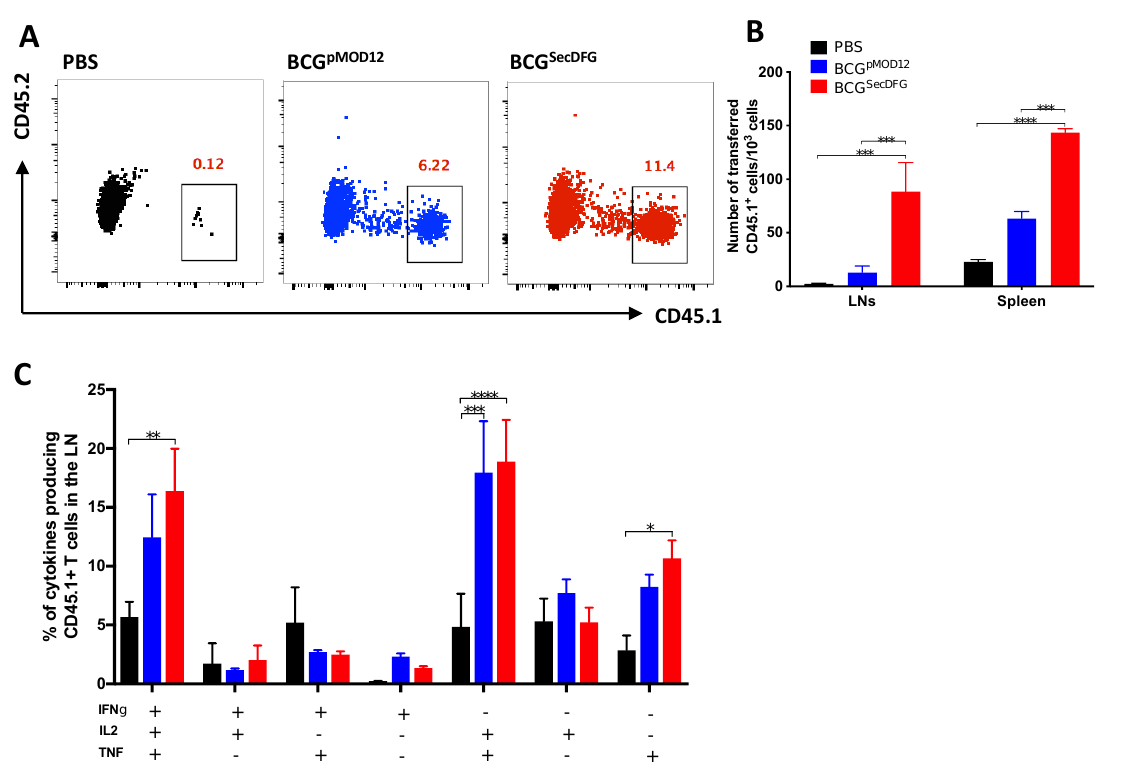
Figure 3. Expansion of transferred p25-specific CD4 + T cells following BCG SecDFG vaccination. Approximately 5 × 10 5 CFSE-labeled p25 splenocytes (CD45.1 + ) were transferred via i.v. injection to C57BL/6 (CD45.2 + ) recipient mice ( n = 4) prior to vaccination. The following day, mice were vaccinated s.c. with 5 × 10 5 CFU of BCG pMOD12 or BCG SecDFG , or left unvaccinated. Six days after the vaccination, the numbers of lymphocytes were enumerated in the DLNs and spleens. Representative flow plots are shown ( A ), together with CD45.1 + P25-specific CD4 + T numbers ( B ), as measured by flow cytometry. ( C ). Intracellular cytokine staining was performed on lung cells at 4 weeks post-infection after re-stimulation with CFP (10 μ g/mL) and Brefeldin A, and the frequency of IFN- γ, IL-2, and/or TNF positive CD4 + T cells was assessed. Data are representative of two independent experiments. Statistical significance was determined by ANOVA with Tukey’s multiple -comparisons test (* p < 0.05; ** p < 0.01; *** p < 0.001; **** p < 0.0001; gating strategy is shown in Supplementary